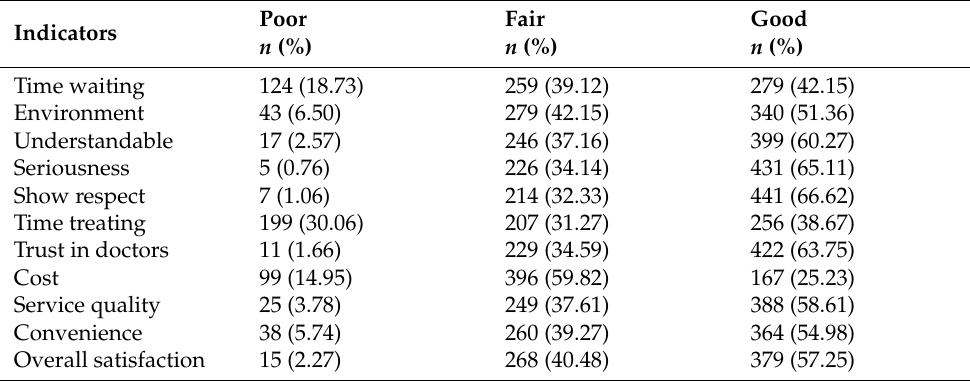
Table 3. Frequency distribution of 11 satisfaction indicators, N = 662.